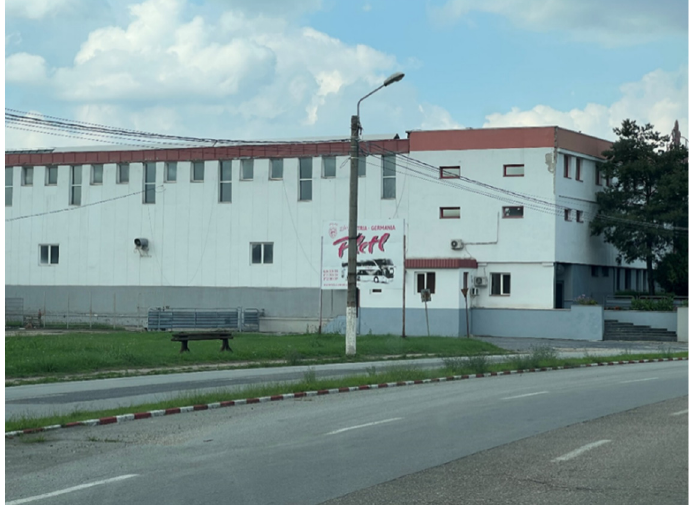
Figure 10 . The former IURT (Lugomet) building regenerated and used by the Rieker Company until 2019 is now vacant and available for further investment in services or industry (photo taken by author, 2022).